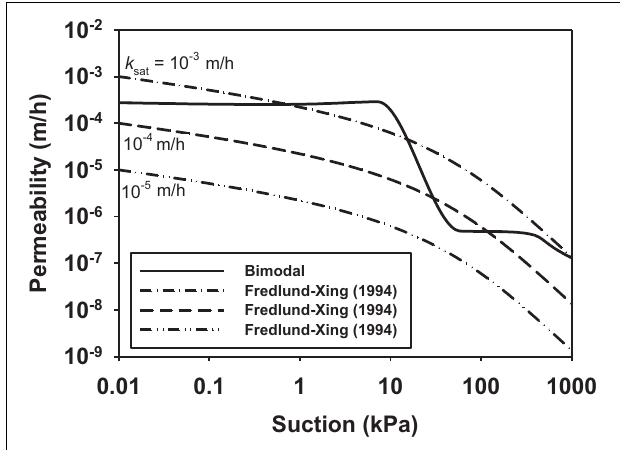
FIGURE 4 | Unimodal and bimodal permeability functions used in the present study.